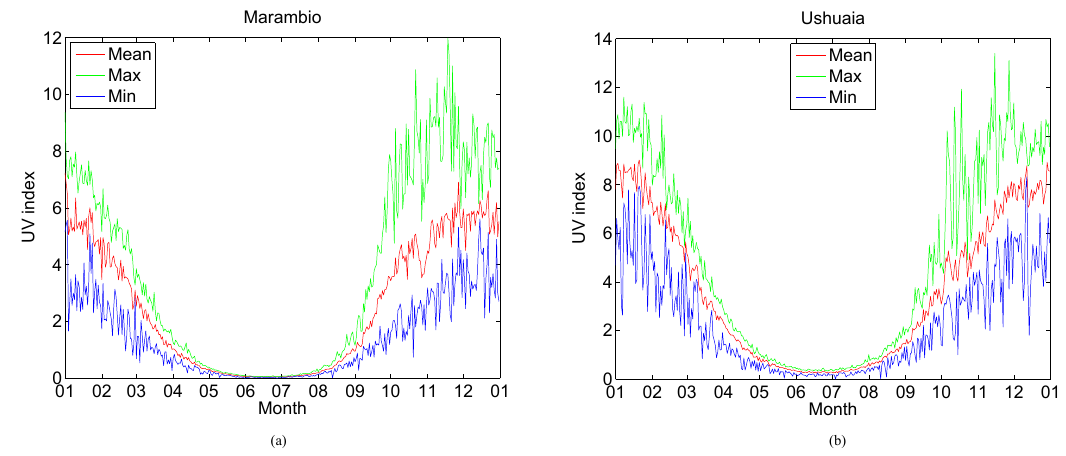
Figure 7. The mean, maximum and minimum values of the daily maximum UV index calculated for each day of the year in the period 2000–2010 in (a) Marambio and (b) Ushuaia.